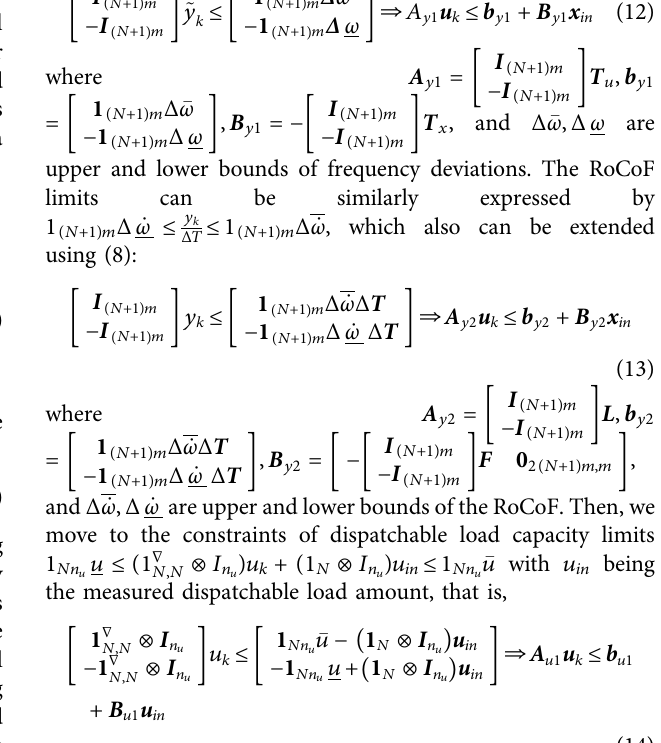
Frontiers in Energy Research |